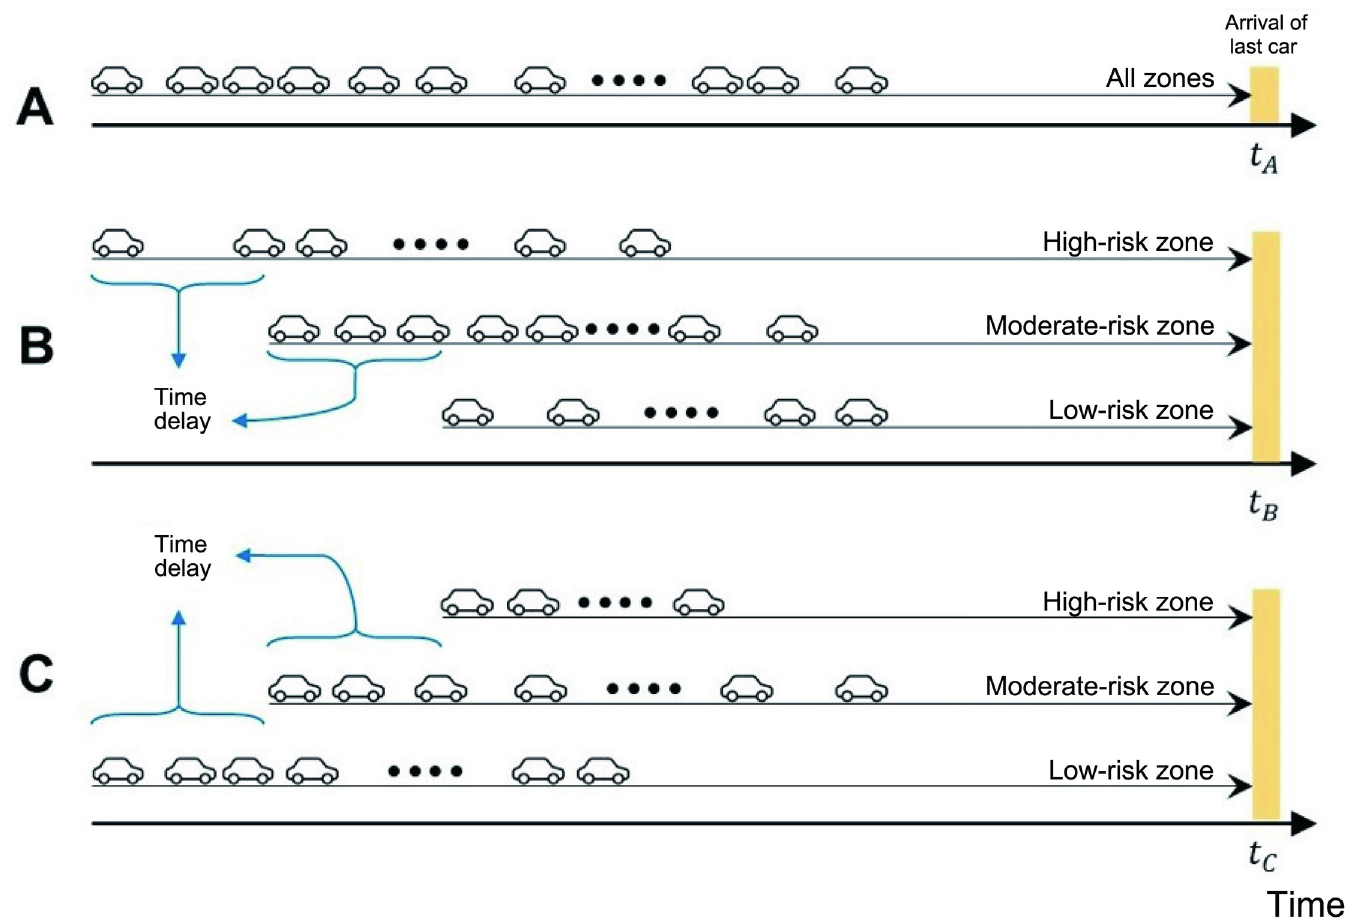
Fig 2. Schematic diagram of the various evacuation institutional arrangements. (A) Simultaneous evacuation, (B) staged evacuation in order of high-risk, moderate- risk, and low-risk zones (HML), and (C) staged evacuation in order of low-risk, moderate-risk, and high-risk regions (LMH). The black cars are the individual agents departing at the corresponding times. A yellow line indicates the final arrival time of the last evacuee. t respectively. The blue ranges denote the time delays between the various zones.